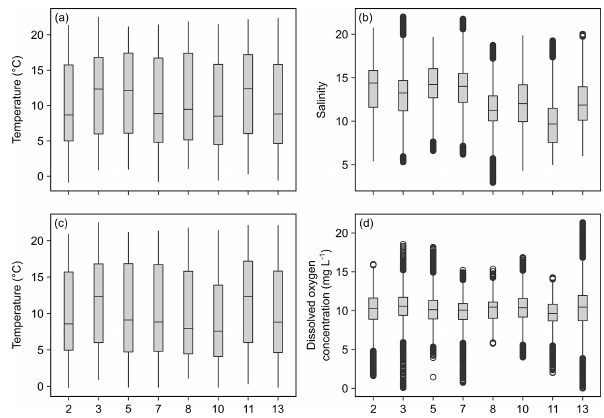
Figure 6. Box plots of temperature, salinity and dissolved oxy- gen concentration recorded over the monitoring period by DST CT (a, b) and MiniDOT (c, d) data loggers, respectively. X axis indicates station numbers. Boxes indicate median, first and third quartile. Whiskers show values within and dots values outside 1.5- times interquartile range. Note that only data with quality flag = 1 were